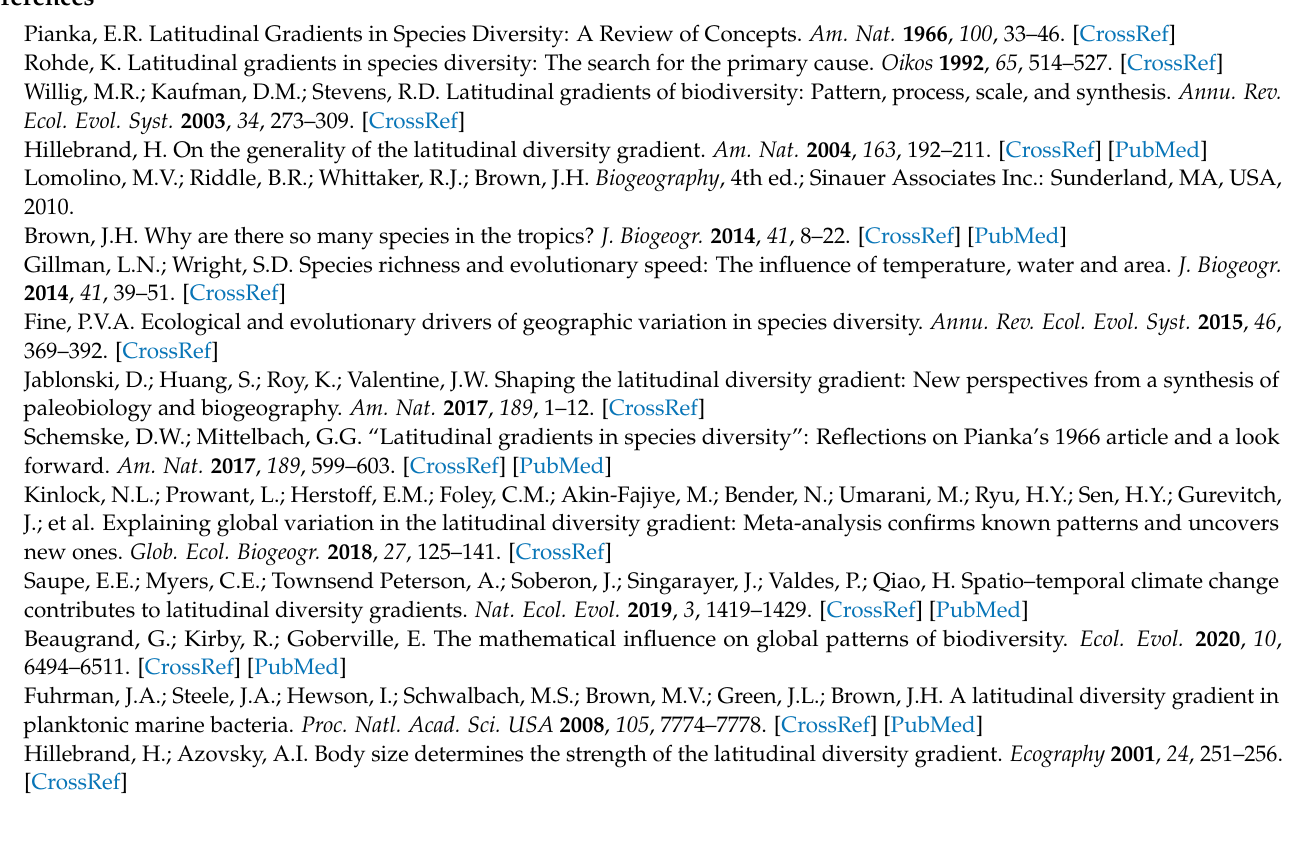
Figure S1: Global pattern of earwig species richness by country. Figure S2: Latitudinal patterns of variation in average annual temperature (a) and precipitation (b) by country. Regression equations are given in Table S2. Figure S3: Relationship between earwig diversity and average annual temperature at global level. Regression equation is given in Table S2. Figure S4: Relationships between earwig diversity and precipitation. Regression equations are given in Table